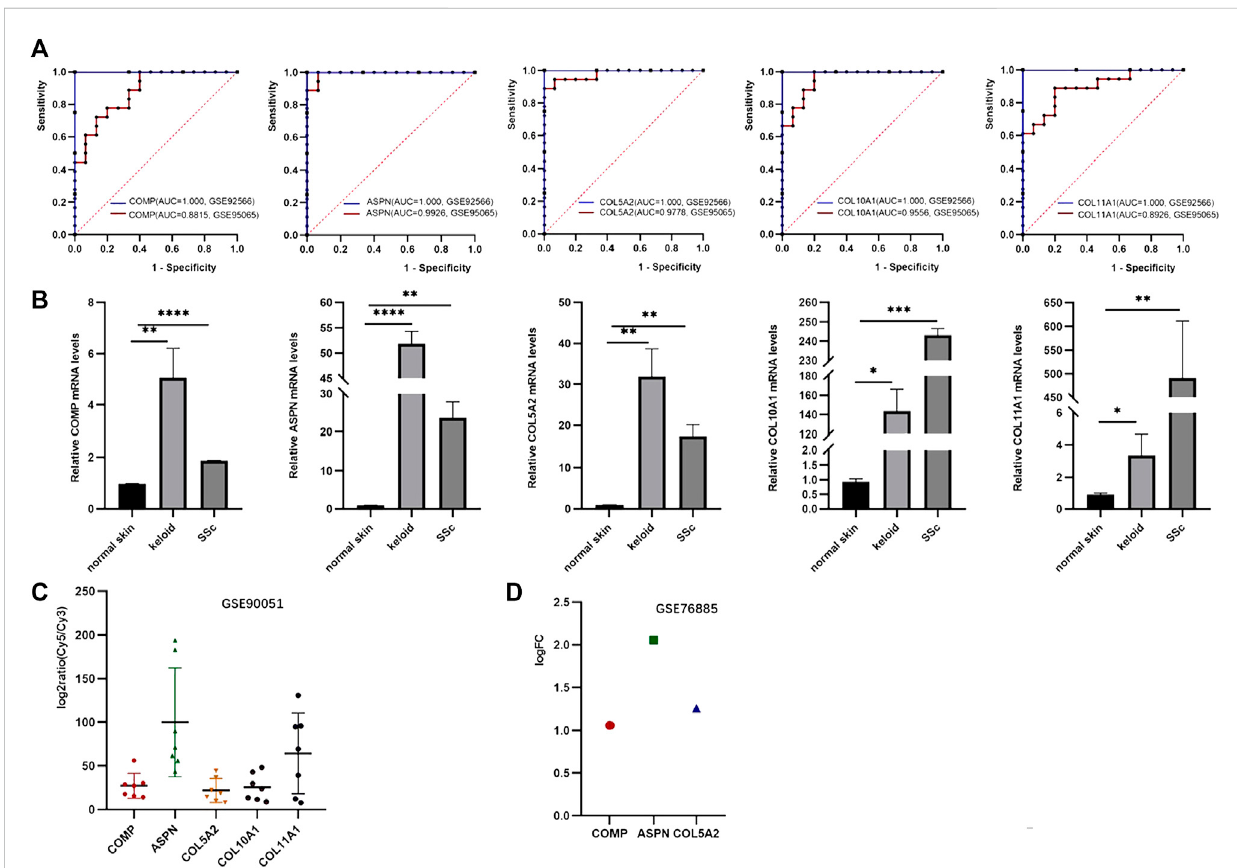
FIGURE 6 Validation of hub genes. (A) ROC curves demonstrating the diagnostic value of the hub genes. (B) Expression level of hub genes validated by qPCR. (C) Hub gene validation in the GSE90051 dataset. (D) Hub gene validation in the GSE76855